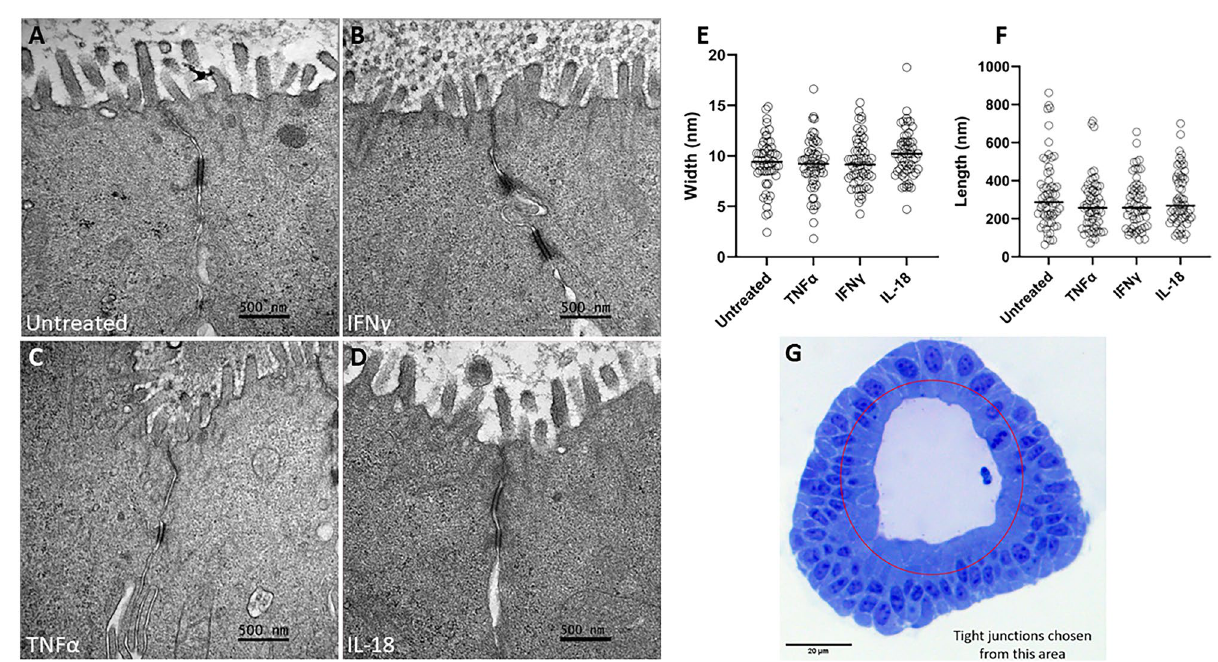
Figure 5. Cytokine treatment does not alter junctional morphology as measured by transmission electron microscopy. ( A–D ) Representative TEM images of cytokine-treated intestinal organoid tight junctions. Scale bars denote 500 nm. ( E ) Tight junction width. ( F ) Tight junction length. ( G ) Light microscopy image of a bovine intestinal organoid highlighting the apical area from which tight junctions were analyzed. Scale bar denotes 20 µm. Cytokine treatment did not induce a significant change in junctional length or width as determined by Kruskal–Wallis non-parametric ANOVA (α =